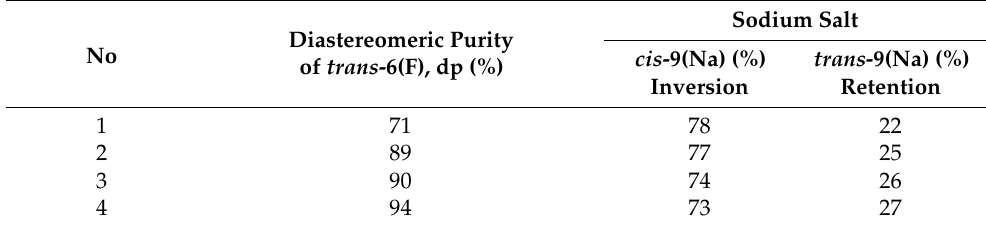
Table 3. Effect of diastereomeric purity of thiophosphoryl fluoride trans - 6 ( F ) on percentage of cis - and trans -isomers of thioacid 9 sodium salt.